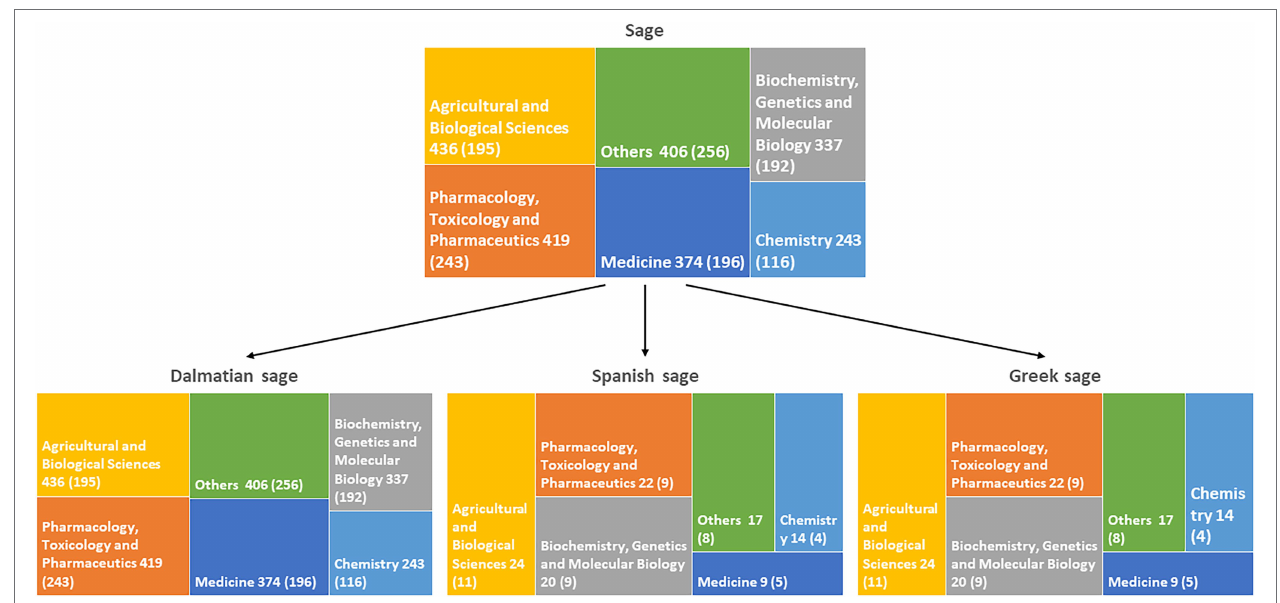
FIGURE 1 | Numbers of studies by subject area on Salvia genus and species reviewed here. Numbers of studies since 2012 are indicated in the